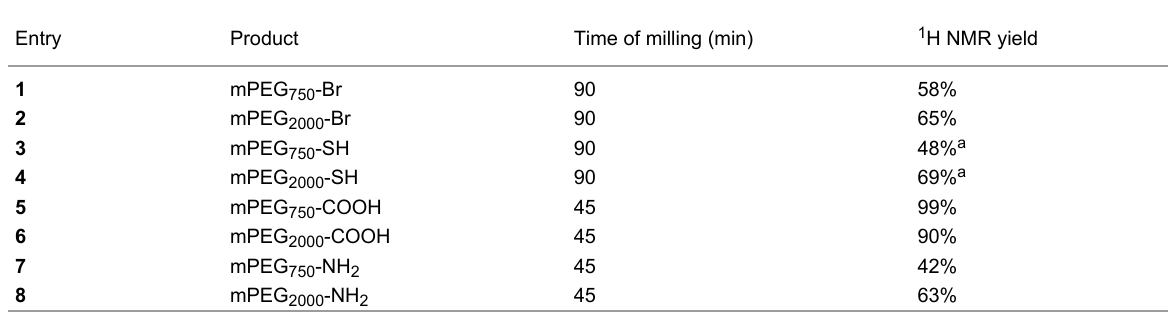
Table 2: Surveyed reactions of mechanochemical derivatization to afford mPEG–Br, –SH, –COOH and –NH 2 derivatives.